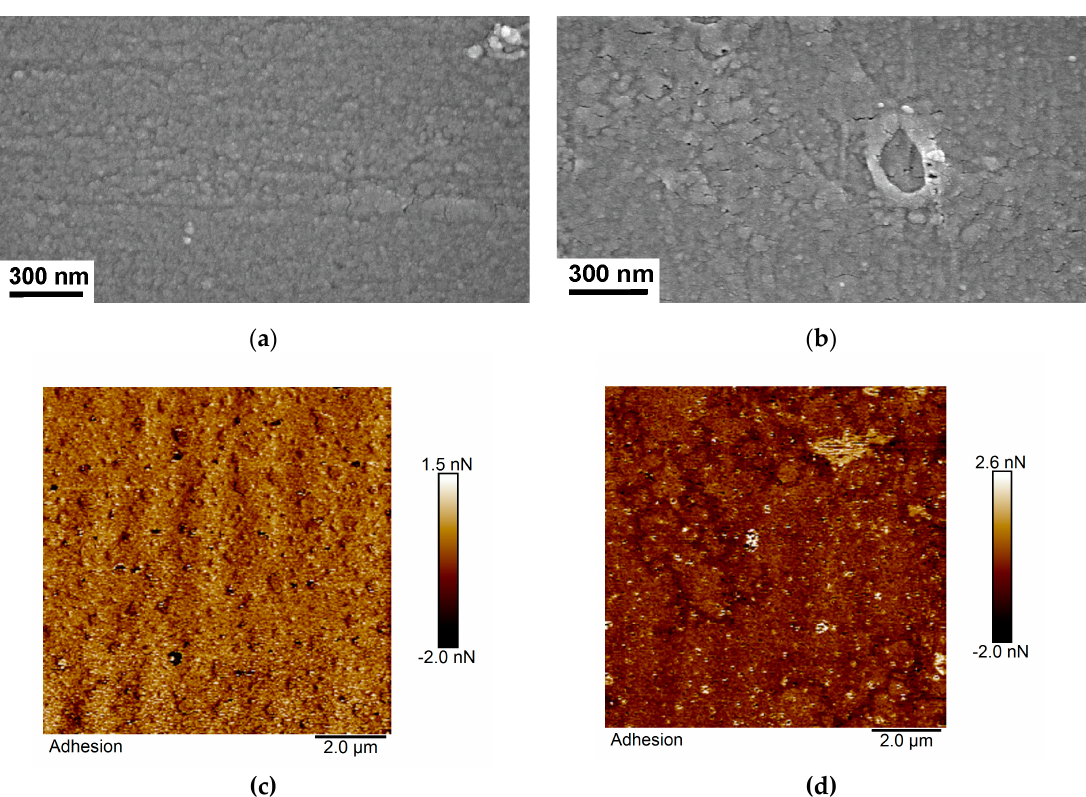
Figure 4. SEM ( a , b ) and AFM ( c , d ) images of the surface of a glassy carbon electrode modified with polyaniline ( a , c ) and polyaniline with P[6]A and a Cu 2+ coating ( b , d ).